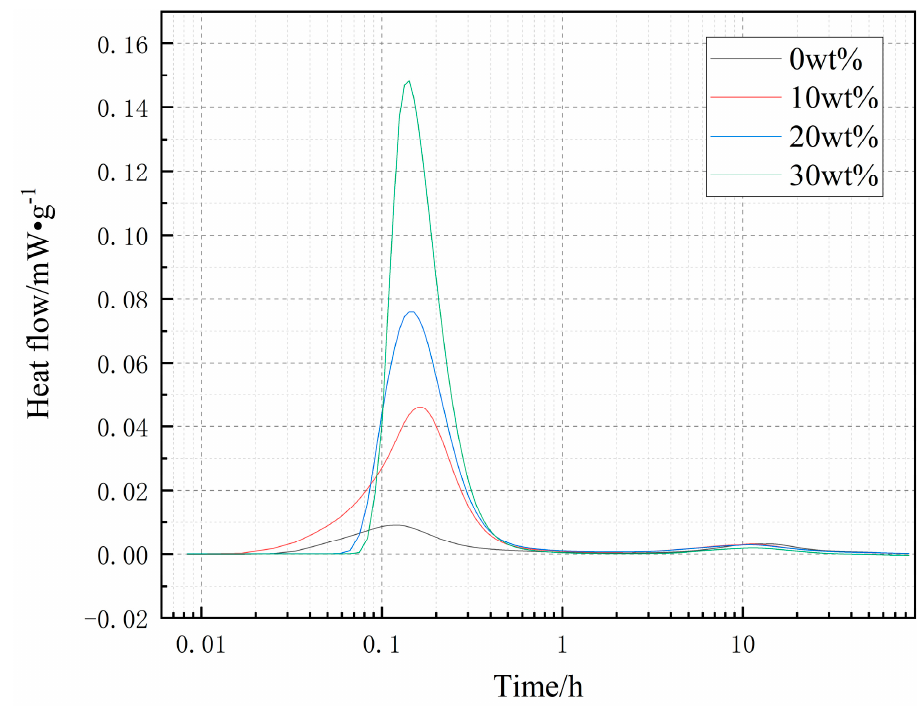
Figure 3. Heat of hydration curve of cement with different dosage.